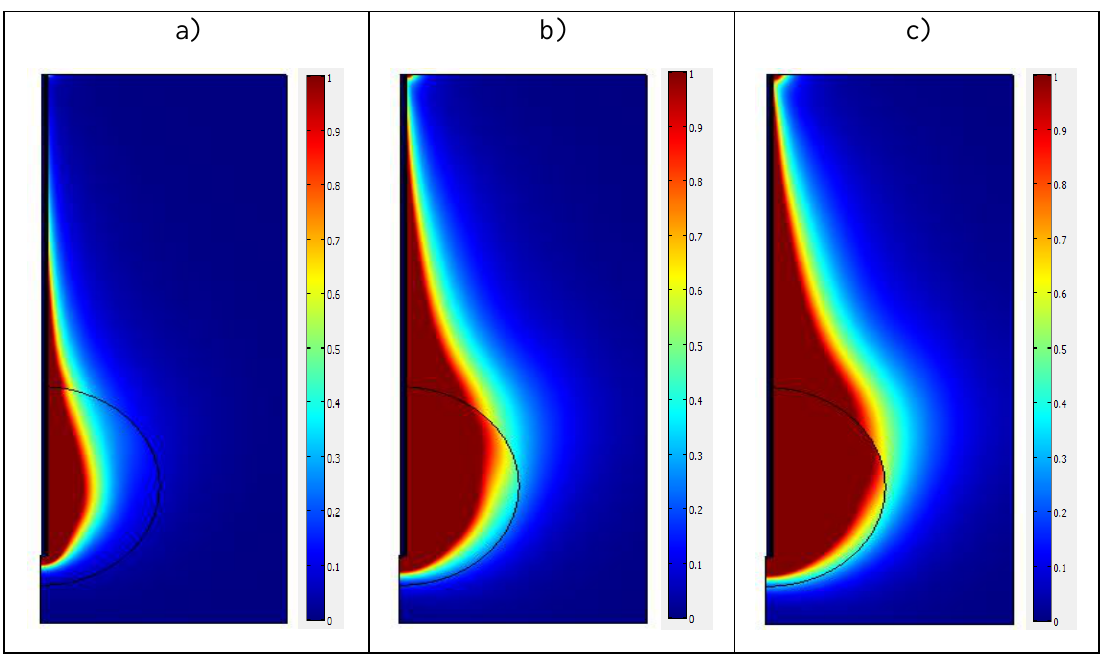
Figure 7. Microwave power density absorbed in liver tissue for various input powers P in : ( a ) P in = 10 W, ( b ) P in = 45, and ( c ) P in = 75 W .